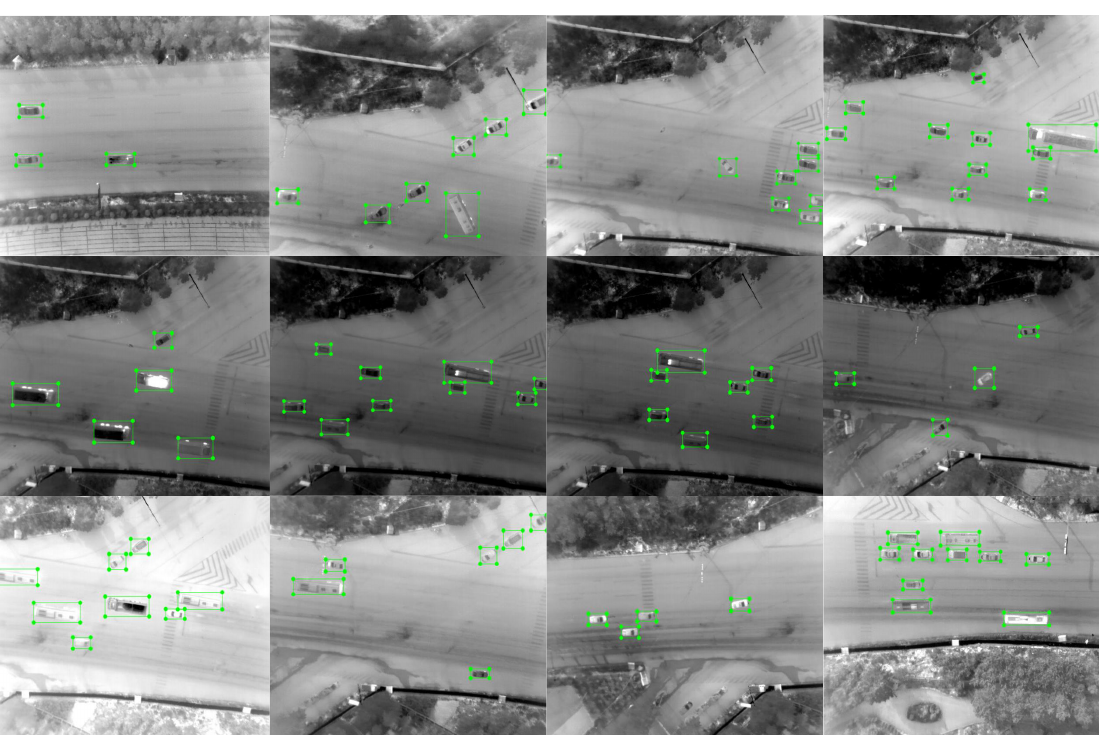
Figure 3. The labeled vehicle samples captured by the unmanned aerial vehicle DJI MATRICE-100. The manual label process is accomplished by the labelimg toolbox, which is a widely used tool in the sample label. Firstly, the label "vehicle" is written in this tool before label process. Then, we put green rectangles around the vehicles in images by searching the two locations: the left-top corner and the right-bottom corner. Finally, we keep this position and label information in a xml format like the